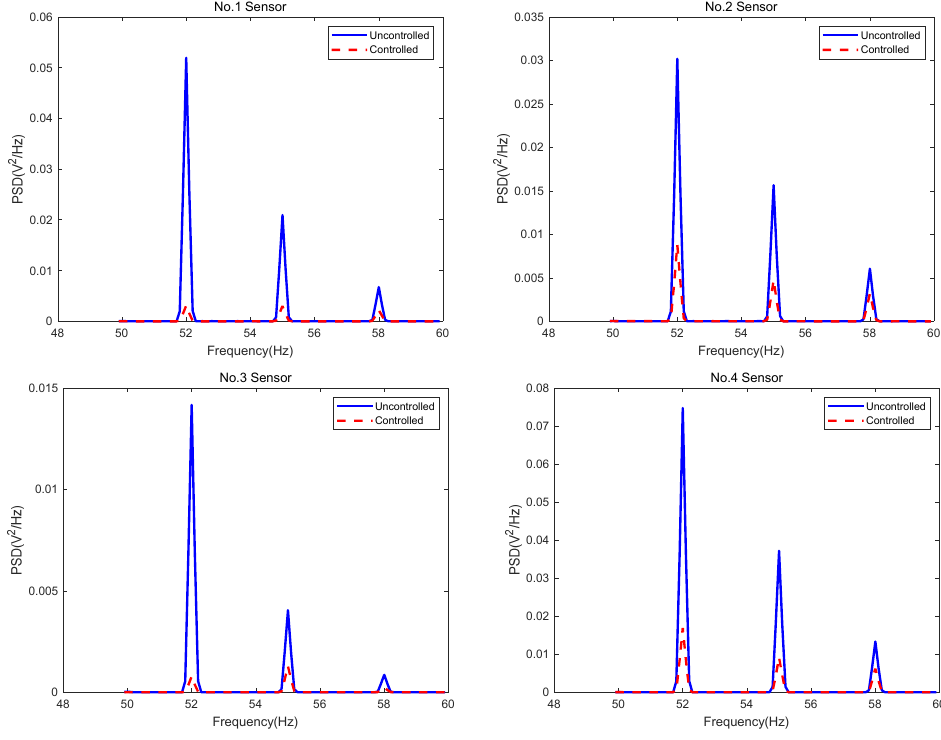
Figure 14. PSDs of sensor signals obtained by experiments. Figure 13. Sensor signals obtained by experiments (1 mV represents 0.1 m/s 2 ). Table 3. RMS values of sensor signals: Experiment #1.